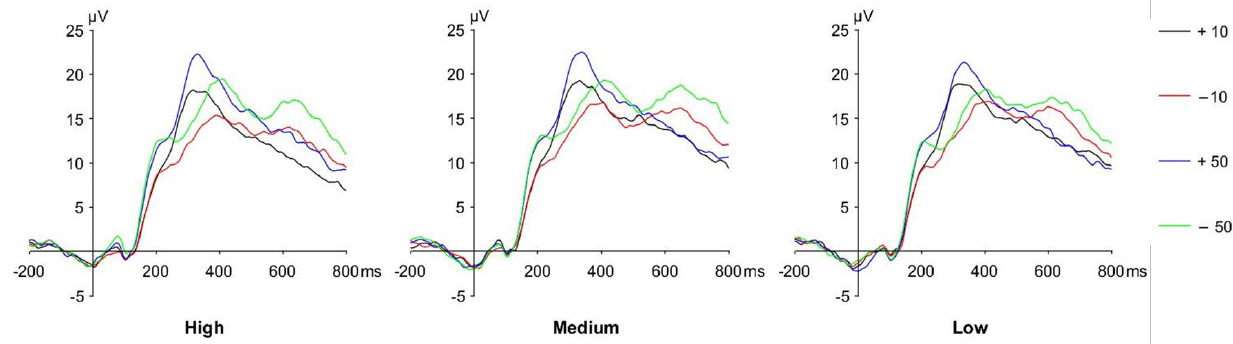
Figure 4. The grand average ERP waveforms of different time constraint conditions. The average FRN amplitude and latency under different time pressures are shown in Figure 5. The average FRN amplitudes of high, medium, and low time constraint conditions are, respectively, (12.533 ± 1.064) μV, (7.793 ± 1.072) μV, and (7.275 ± 0.937) μV. The average FRN latency of high, medium, and low time constraint conditions are, respectively, (284.480 ± 3.530) ms, (287.684 ± 3.553) ms, and (287.053 ± 3.387) ms. The average FRN of Time Pressure × Valence and Time Pressure × Magnitude are, respectively, shown in Figures 6 and 7.